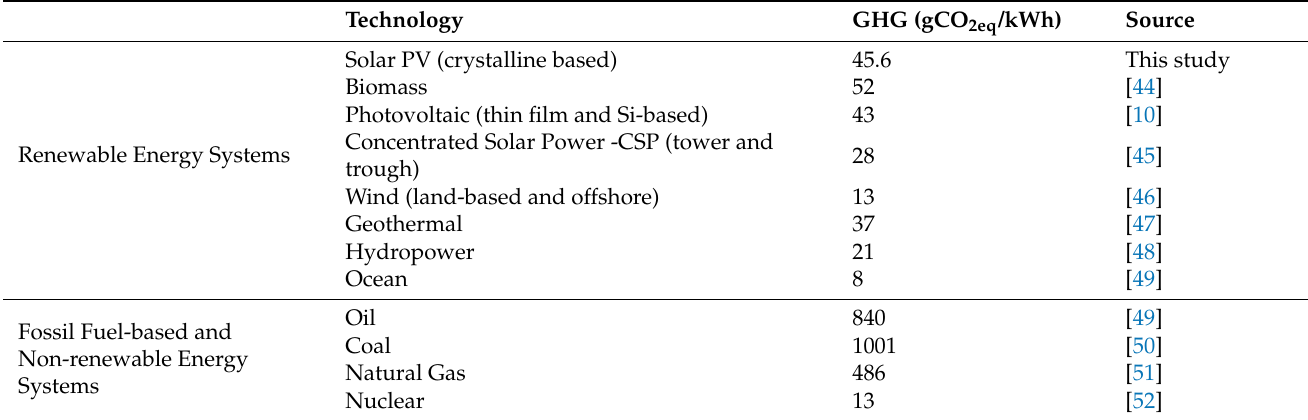
Table 6. Comparison of this study’s life cycle greenhouse gas (GHG) emissions with other renewable and non-renewable electricity generation